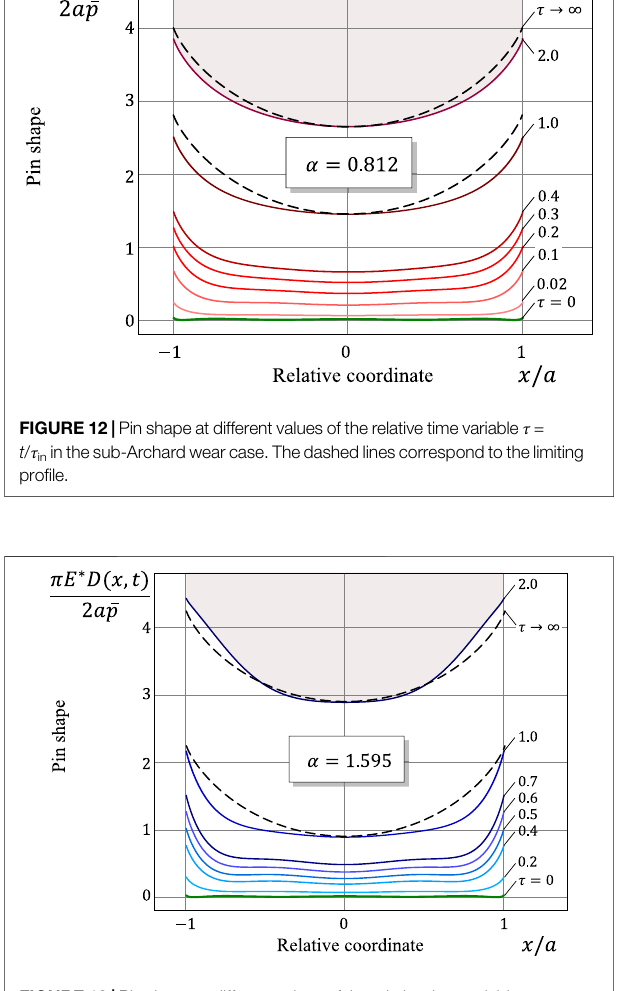
FIGURE 13 | Pin shape at different values of the relative time variable τ = t / τ in in the super-Archard wear case. The dashed lines correspond to the limiting pro fi le.